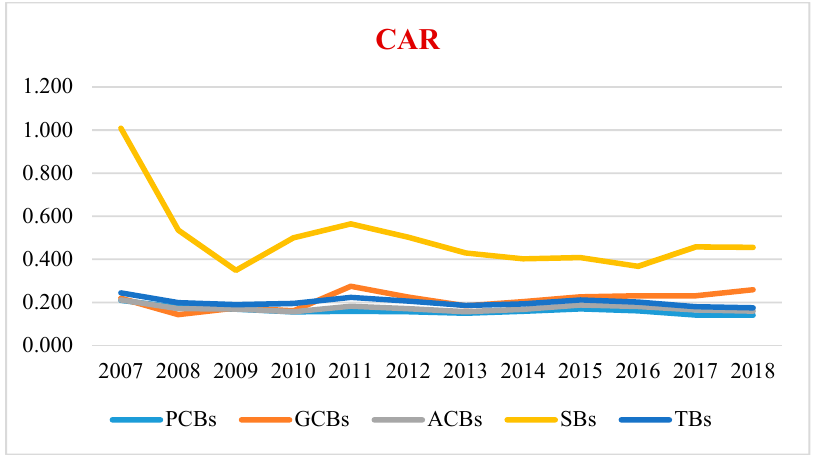
Figure 2. Comparative trends of the Capital Adequacy Ratio (CAR) (during the study period of 2007–2018).